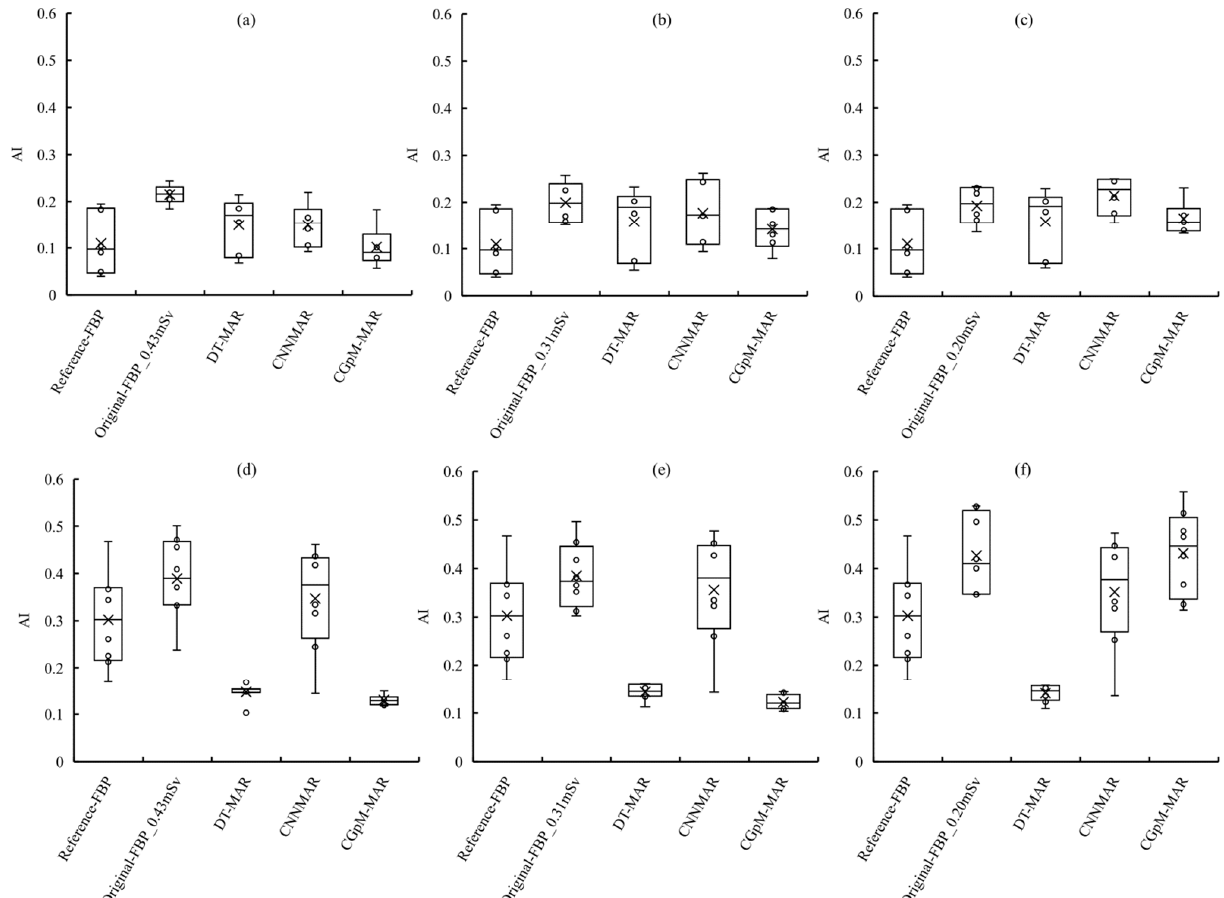
Figure 5. Comparisons of the artifact indexes (AIs) determined for in-focus plane images obtained using the cycle- GAN_pix2pix_MPN (CGpM-MAR) and other traditional reconstruction algorithms with and without metal artifact re- duction (MAR) processing. Metal artifacts originating from the AIs of 6 (ROI_location_1) and 8 (ROI_location_2) selected metal artifact areas (features) and one background area are presented in the in-focus plane. Reference FBP, 0.69 mSv; ( a )